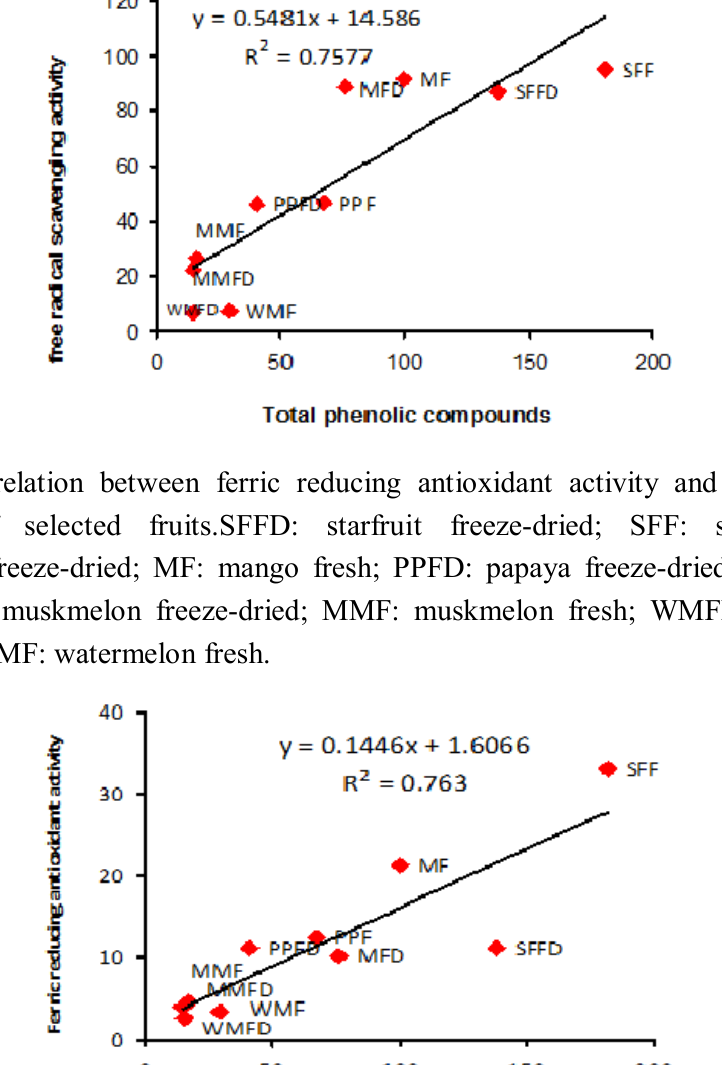
Figure 4. Correlation between free radical scavenging activity and total phenolic compounds of selected fruits.SFFD: starfruit freeze-dried; SFF: starfruit fresh;